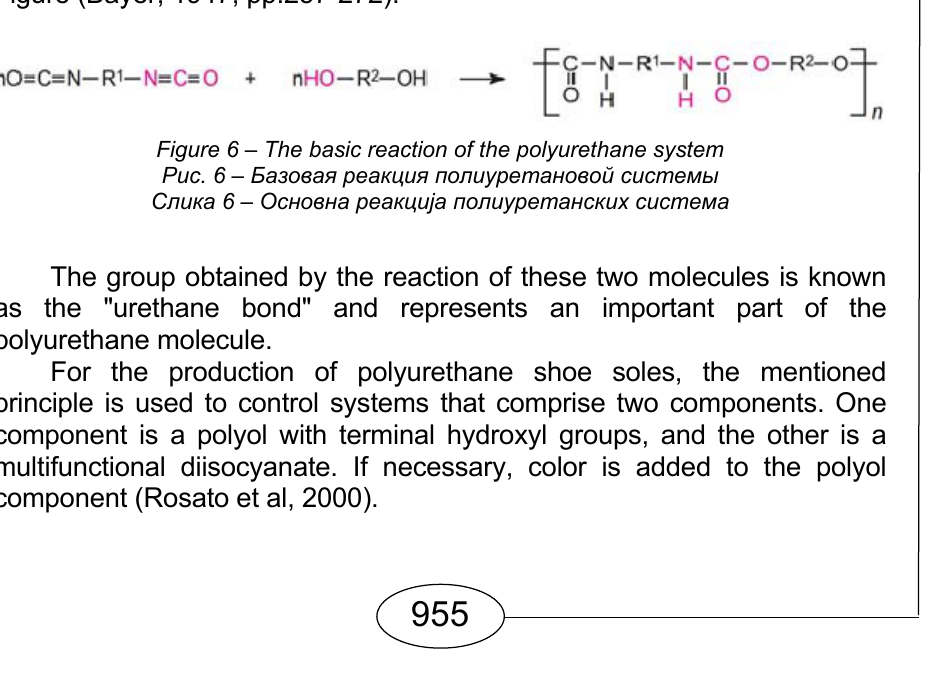
Figure 6 – The basic reaction of the polyurethane system Рис . 6 – Базовая реакция полиуретановой системы Слика 6 – Основна реакција полиуретанских